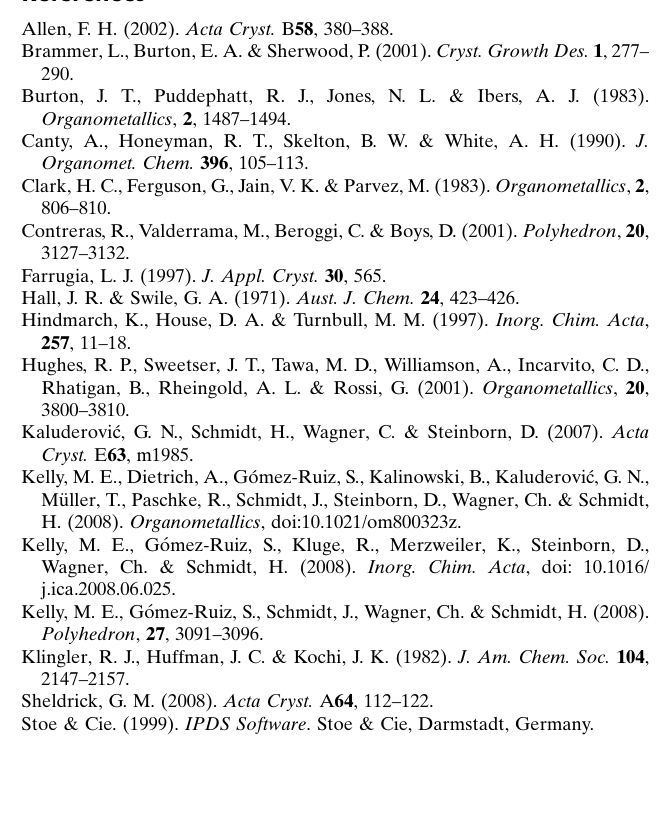
Stoe IPDS diffractometer Absorption correction: numerical